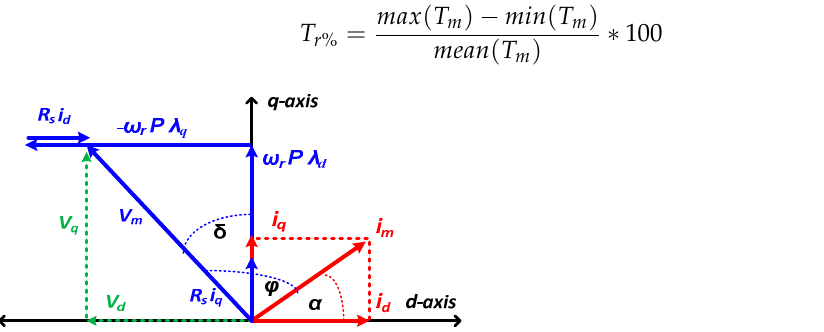
Figure 3. SynRM vector diagram in steady state.